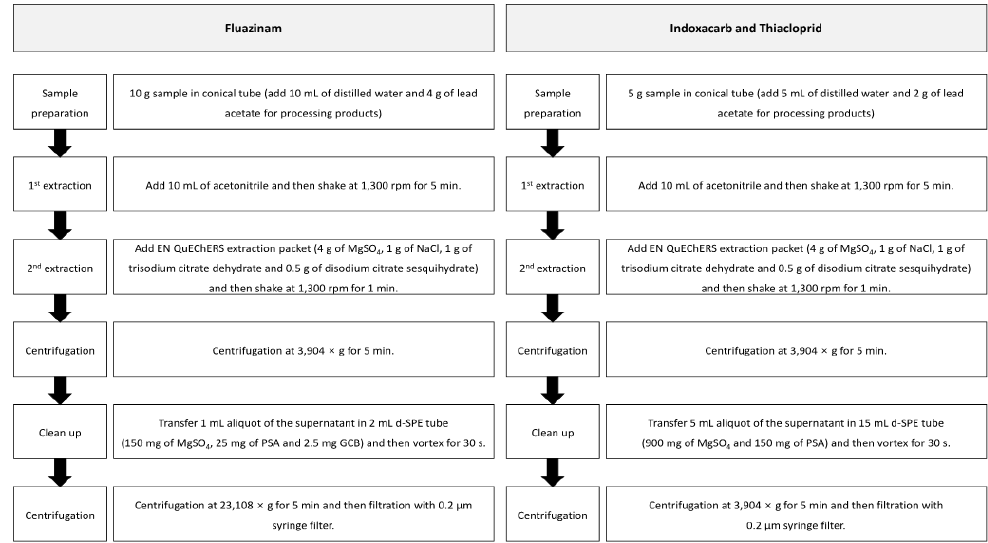
Figure 2. The modified QuEChERS method used for pesticide residue analysis of fluazinam, indoxacarb, and thiacloprid in fresh persimmon and its processing products.